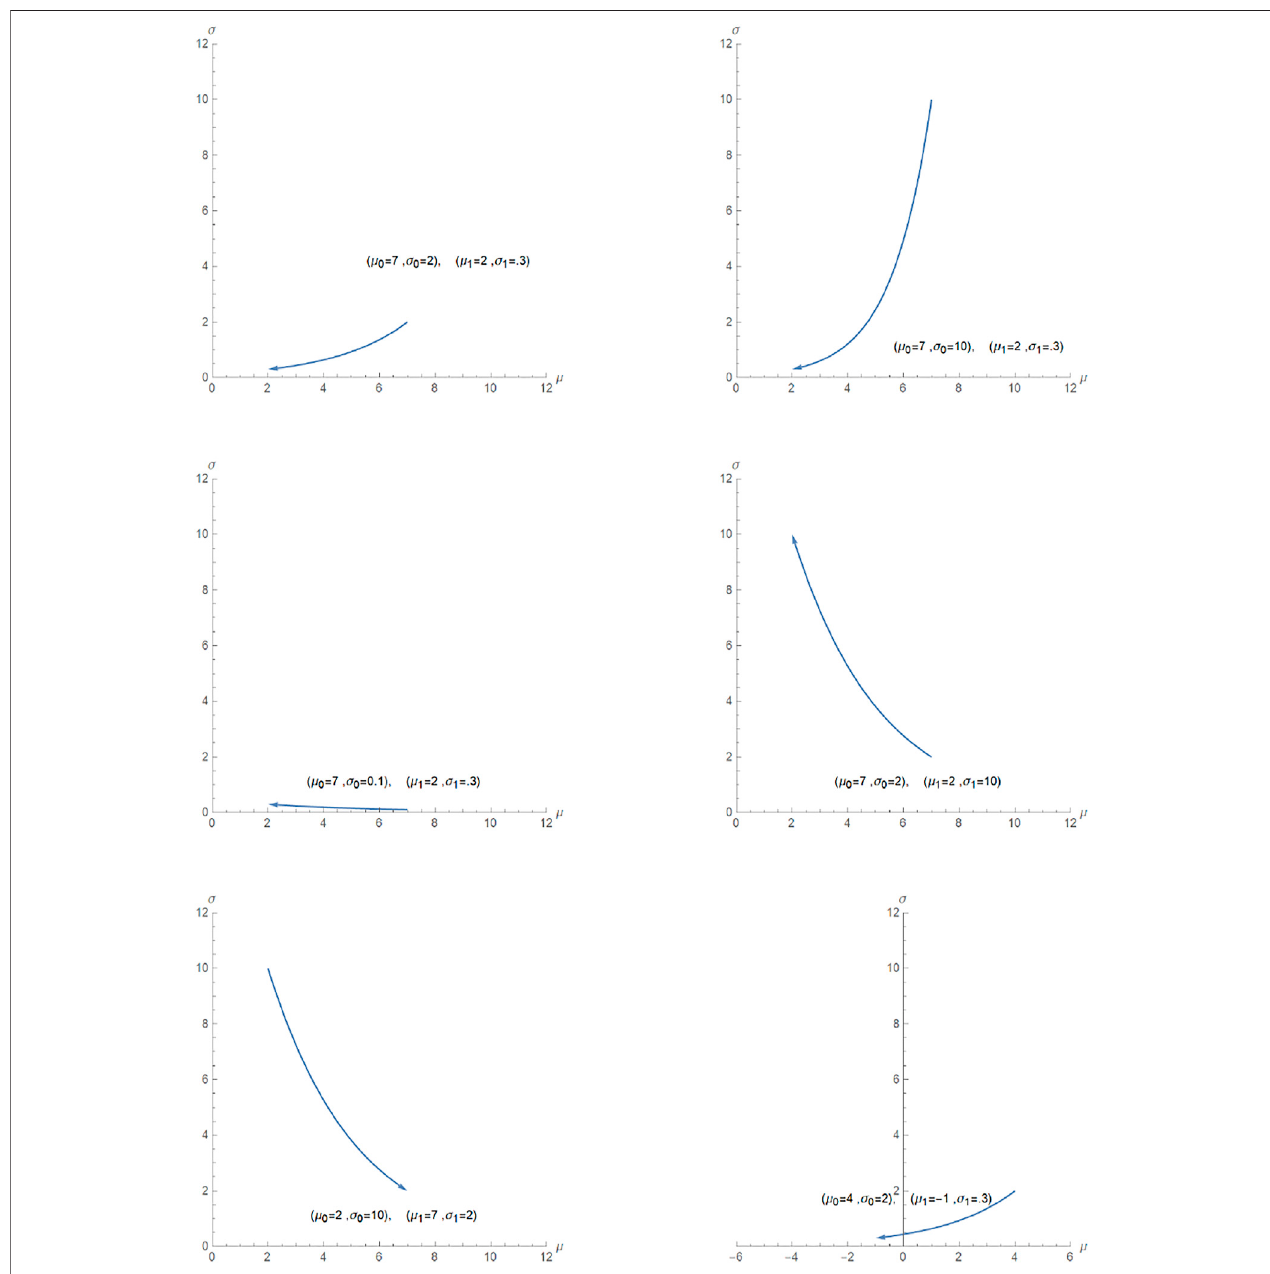
FIGURE 5 | Various